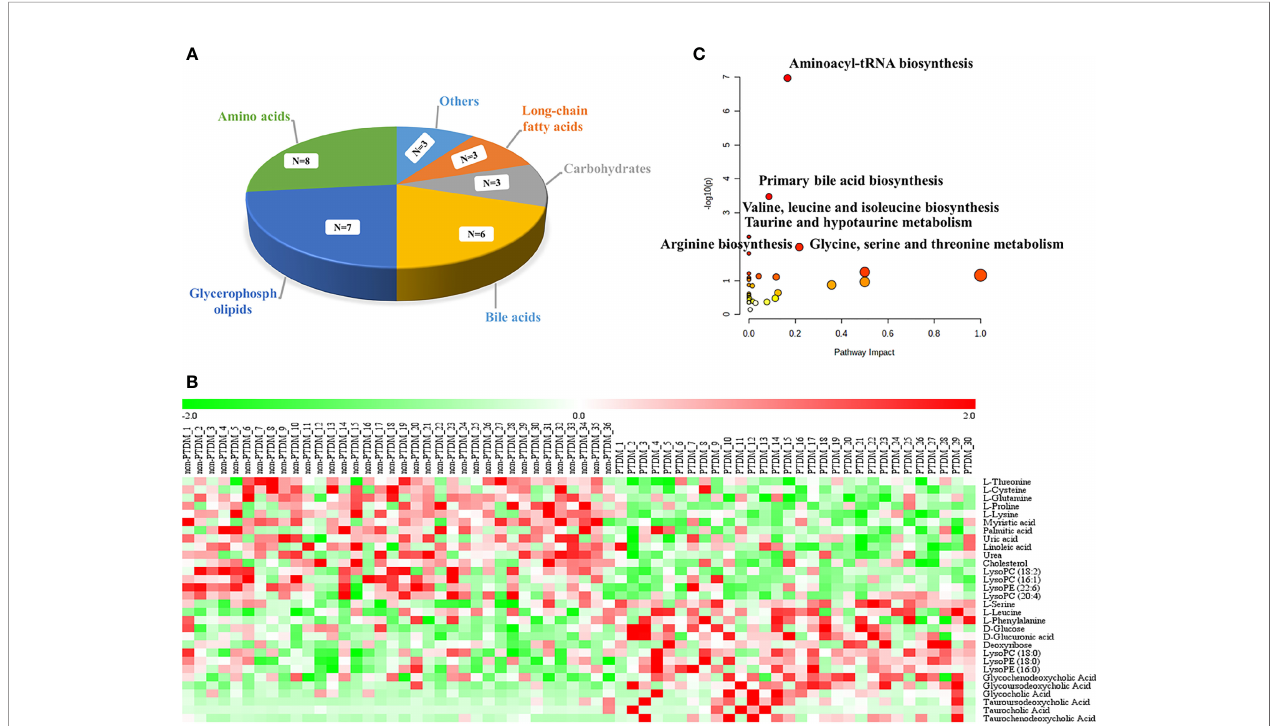
FIGURE 2 | Analysis of the differentially expressed metabolites. (A) classi fi cation of the 30 identi fi ed differentially expressed metabolites; (B) Heat map of the differentially expressed metabolites in each group. Rows, samples; columns, metabolites. The red band indicates an increased level of metabolites, while the green band indicates a decreased level of metabolites in PTDM group compared with non-PTDM group; (C) Summary of the altered metabolism pathways determined with MetaboAnalyst v. 5.0.